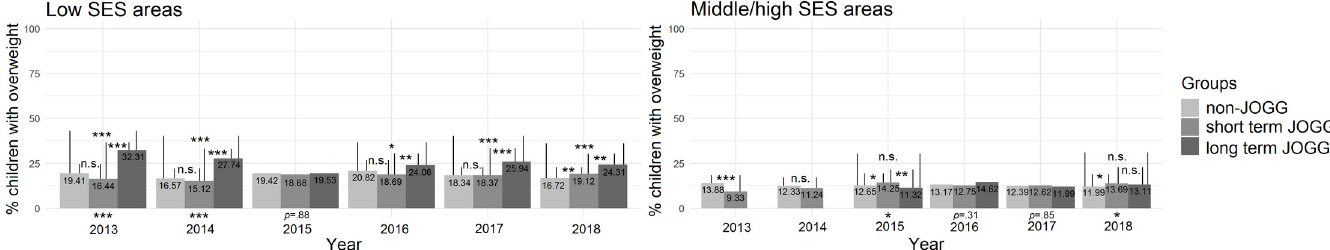
Fig 5. Prevalence of overweight in short-term JOGG areas, long-term JOGG areas and non-JOGG areas, separated by SES. Visual representation of overweight prevalence of non-JOGG areas, short-term JOGG areas, and long-term JOGG areas between 2013–2018, separated by SES. On the left, low SES groups are visualized, while middle/high SES groups are visualized on the right. The statistical significance of the difference between the three groups is expressed below the bars; the results of post-hoc analyses are visualized in the Figure. � p < .05; �� p < .01; ��� p < .001.